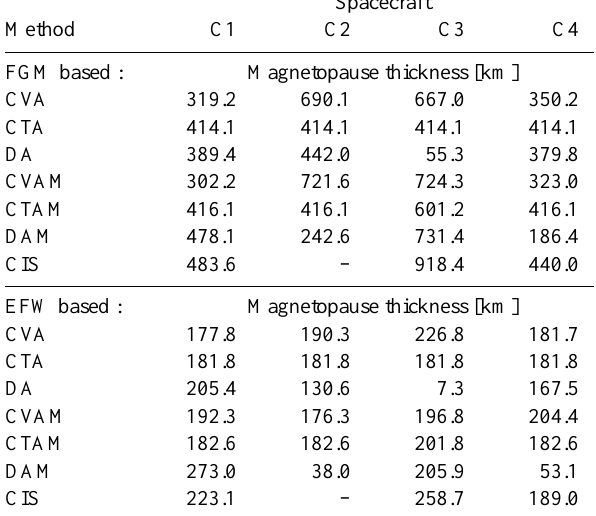
Table 4. Magnetopause thickness based on the durations (from Table 2) and the calculated velocities for the different